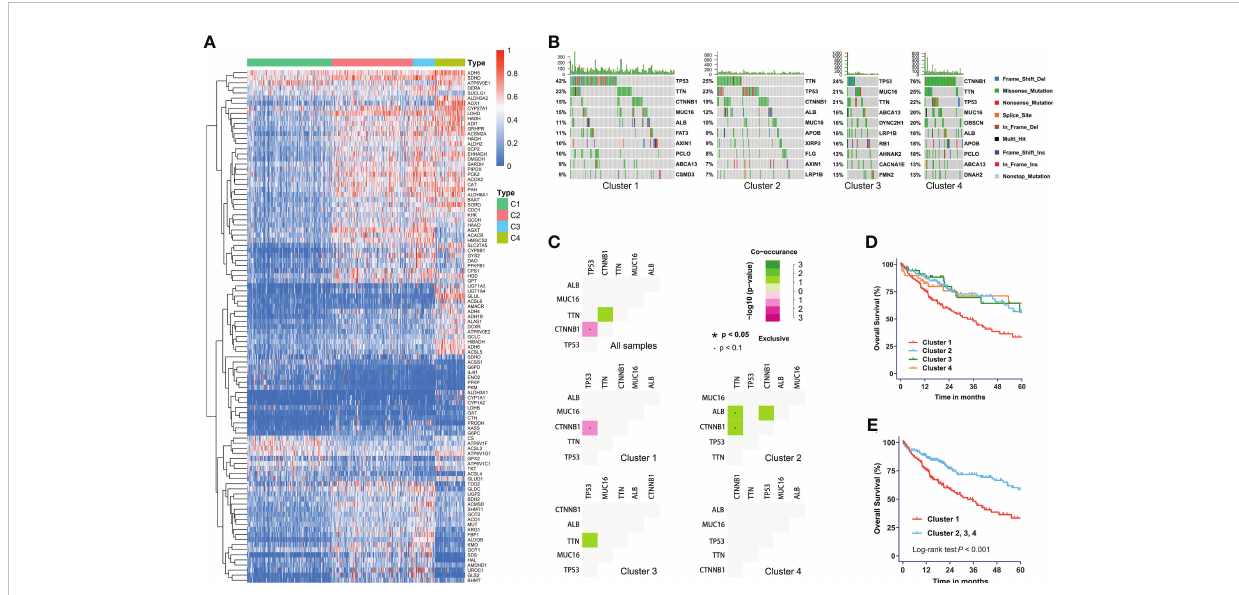
FIGURE 1 The metabolic subtypes in HCC. (A) Unsupervised clustering of HCC samples for 371 HCC patients in the TCGA cohort. (B) Correlation between the distribution of highly variant mutated genes and metabolic subtypes. (C) Co-occurrence analysis of mutations in whole cohort and each subtype. (D) Kaplan-Meier curves with univariate analyses of overall survival in patients strati fi ed by metabolic subgroup. (E) Kaplan-Meier curves with univariate analyses of overall survival in patients of cluster 1 versus those of other three clusters. Log-rank test P values are